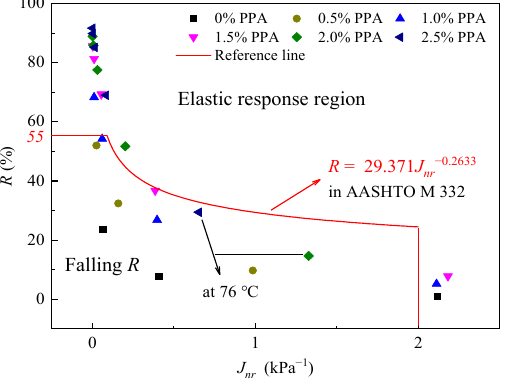
Figure 5. Comparison of J nr ( 3.2 ) and R ( 3.2 ) to assess elastic response.